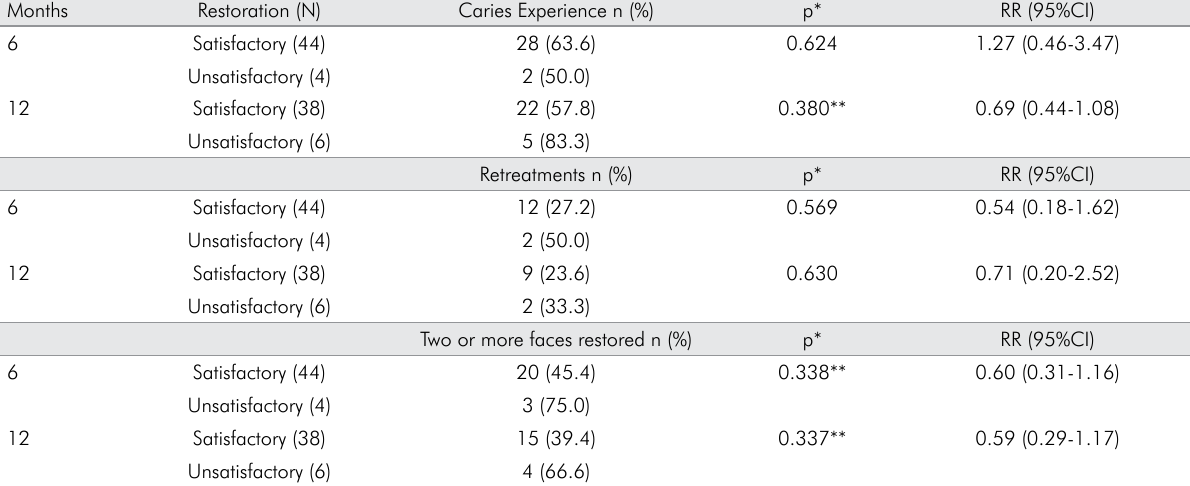
Table 3. Number and percentage of teeth according to caries experience, retreatments and faces restored at baseline, associated with the failed